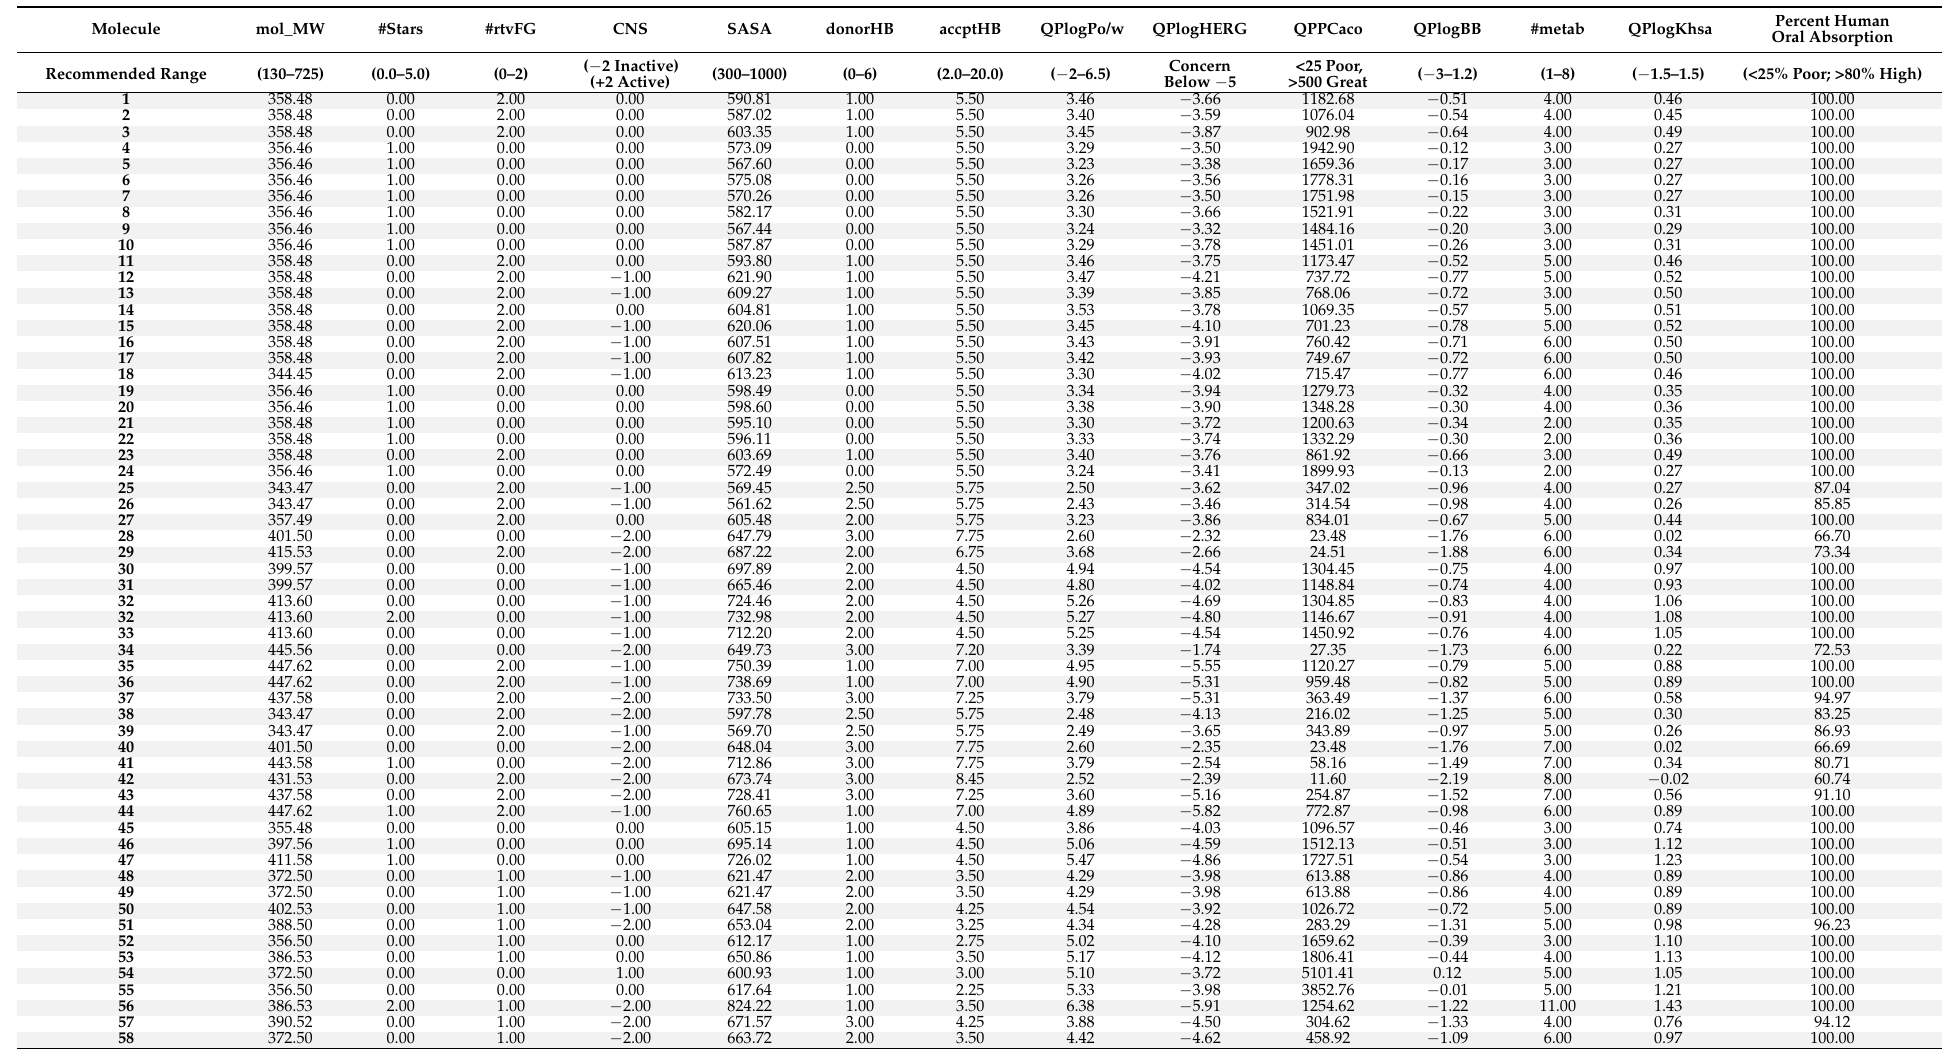
Table 3. ADMET prediction of the tested sesquiterpenes using